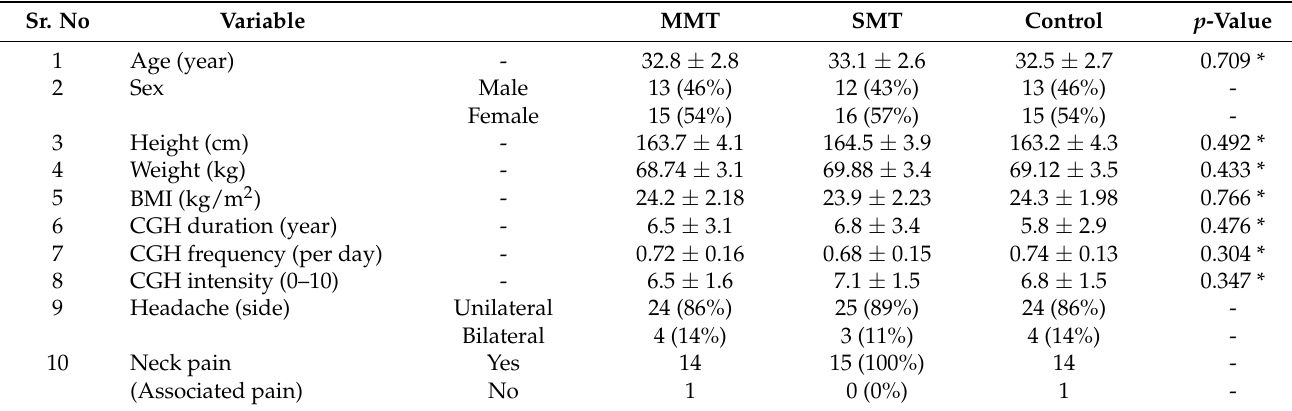
Table 1. Demographic details of the MMT, SMT, and control groups.